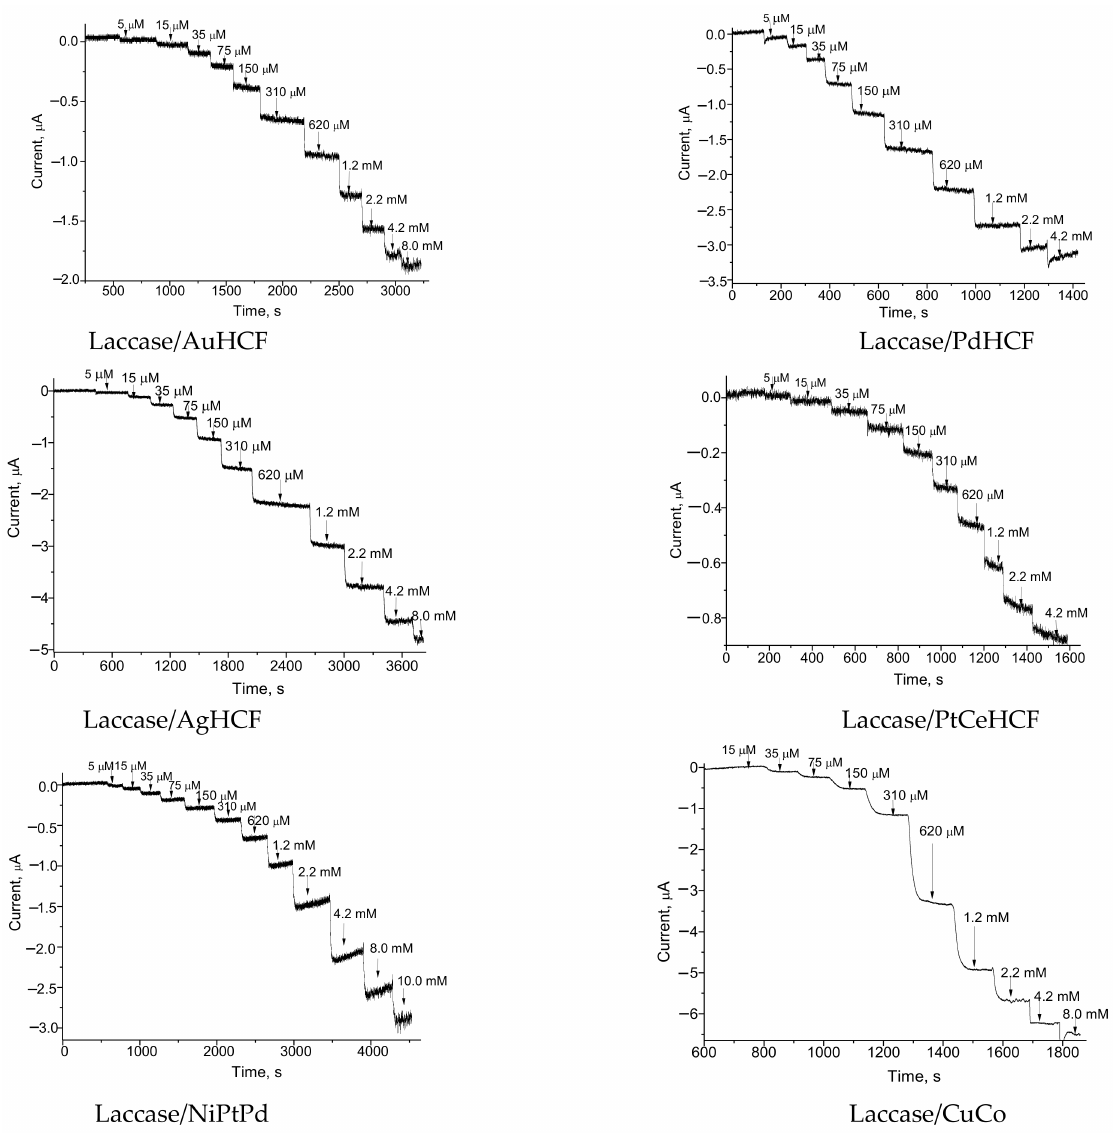
Figure A1. Chronoamperograms of the current responses to catechol addition from the laccase/NP- based ABSs. Conditions: Ag/AgCl (reference electrode) in NaOAc buffer. Working potential: +230 mV.